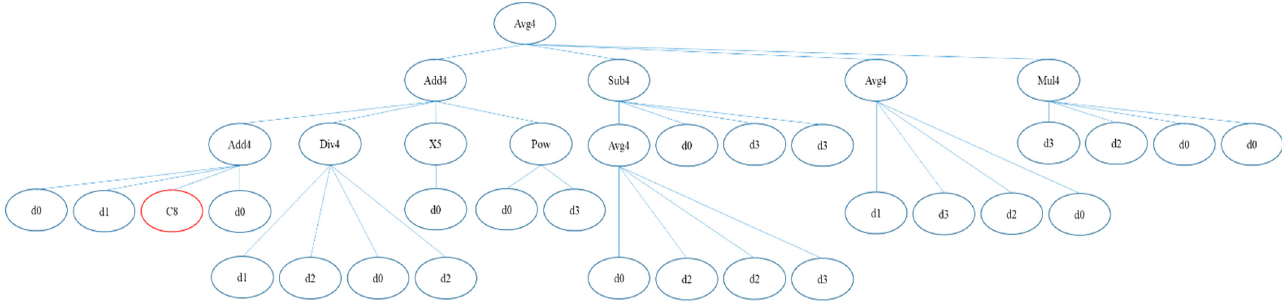
Figure A5. Sub-ET5 of GEP bathymetry retrieval model. Where, Avg is average function, Pow is power function, Nop is no operation, Min is minimize function, Max is maximize function, X3~5 is x to the power of 3~5, Floor is floor function, Pow10 is 10 to the power of x, Exp is exponential function, Atan is arctangent function, Mul is multiplication function, Div is division function, Add is addition function, Sub is subtraction function, Not is complement function, Mod is floating-point remainder function, Sin is sine function, Ln is natural log function, and C1 to C15 is constants, which can be found in Appendix B.